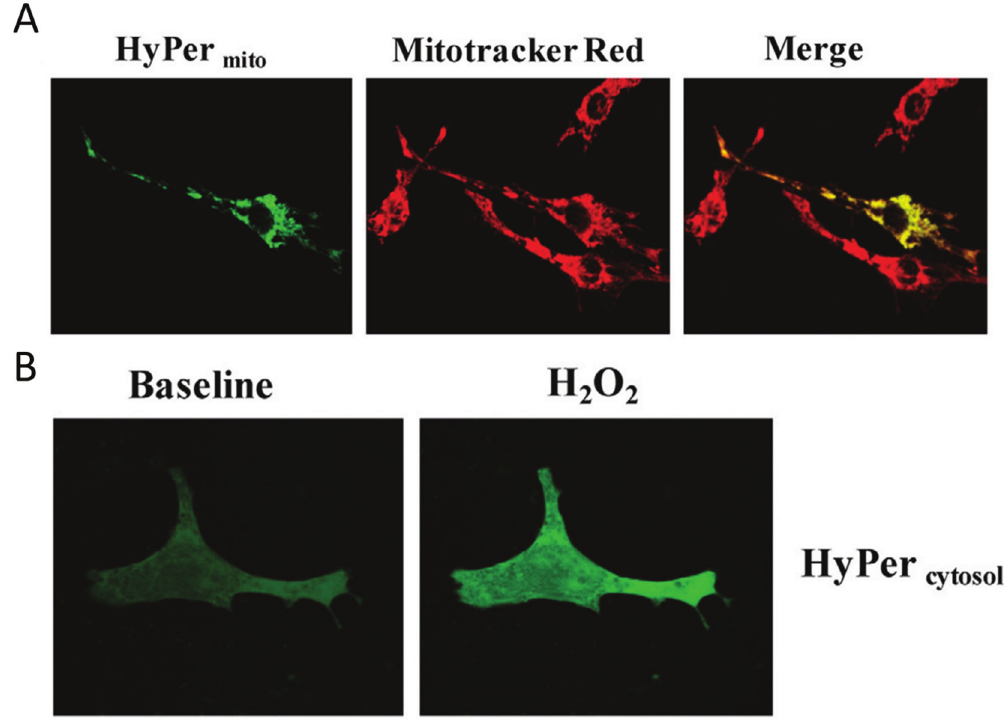
Figure 2. Visualization of H 2 O 2 in subcellular compartments. ( A ) Neonatal rat ventricular cardiomyocytes transfected with the genetically encoded mitochondria targeted H 2 O 2 sensor HyPer mito Mitochondrial localization is confirmed by colocalization with the mitochondrial dye Mitotracker Red. Cells were analyzed after monoamine oxidase ativation with dopamine; ( B ) Neonatal cardiomyocytes expressing cytosol-targeted HyPer cytosol before and after addition of 100 μM H 2 O 2 . Source: Kaludercic et al. , Frontiers in Physiology , 5, article 285 (2014) with